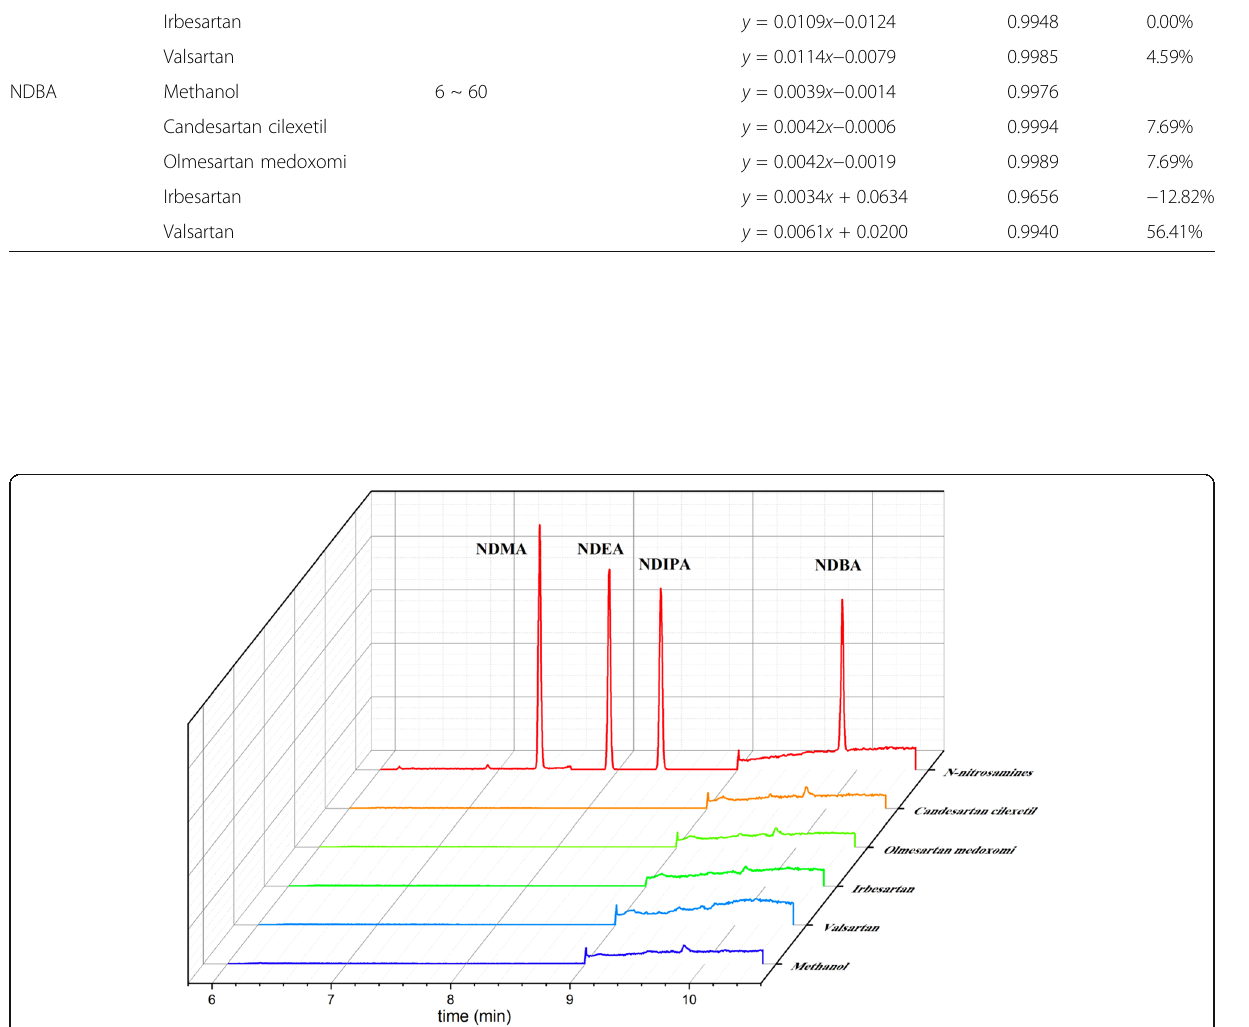
Fig. 2 GC chromatograms of methanol, four sartan substances, and the mixed standard solution of four